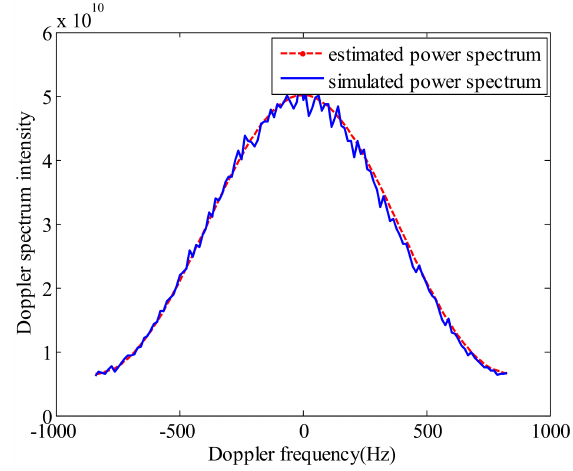
Figure 4. The comparison between the estimated two-way AAP and theoretical two-way AAP model.